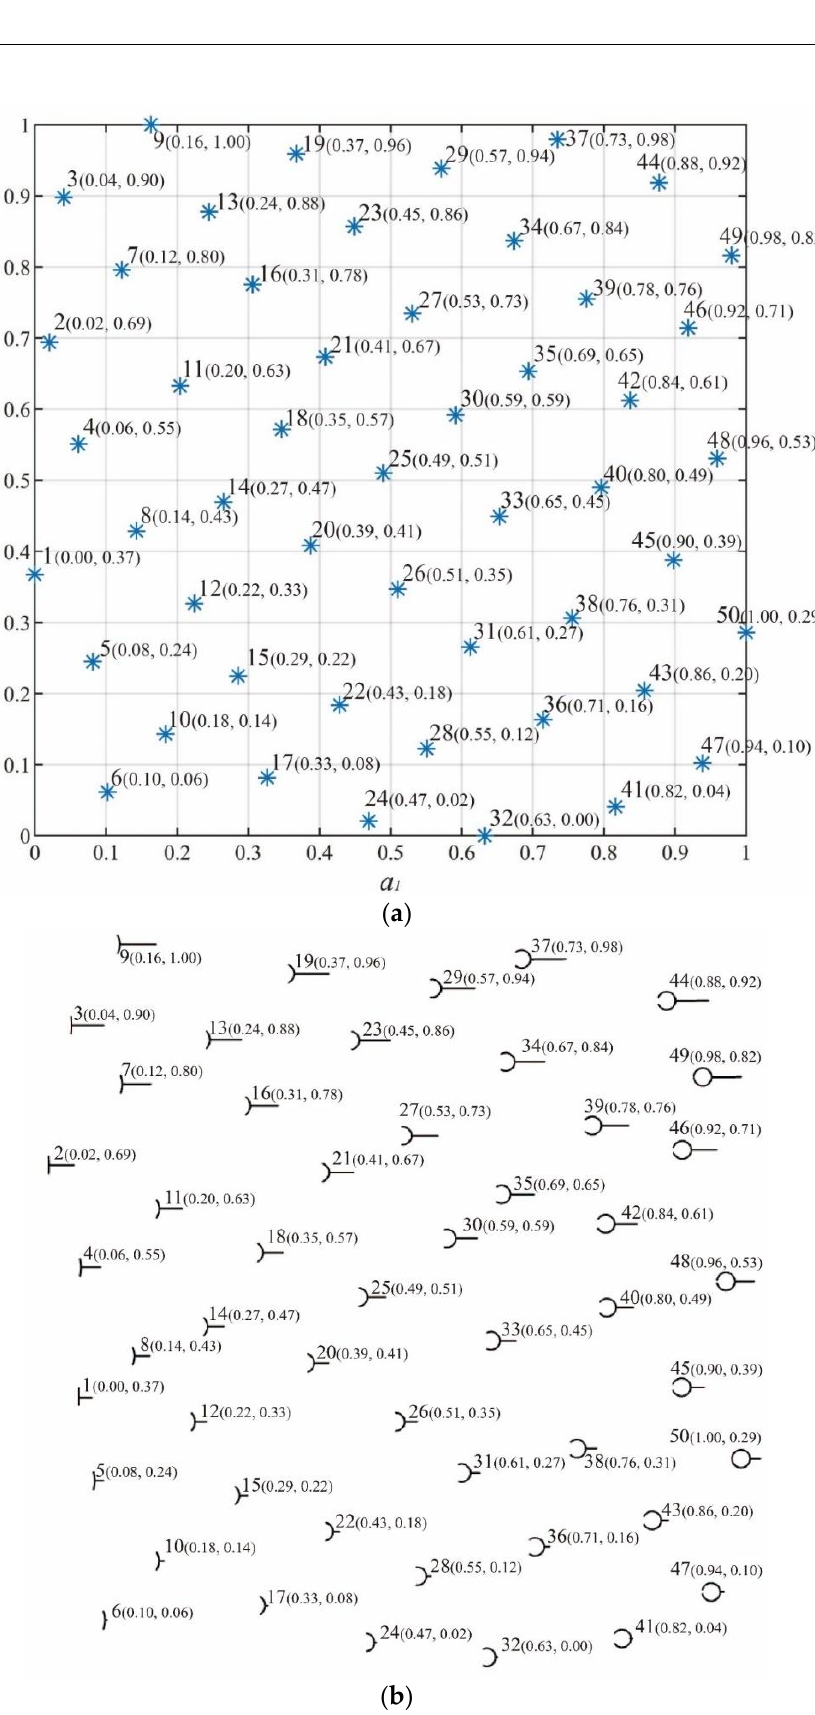
Figure 3. Design of experiments ( a ) samples points and ( b ) shapes of bluff bodies.